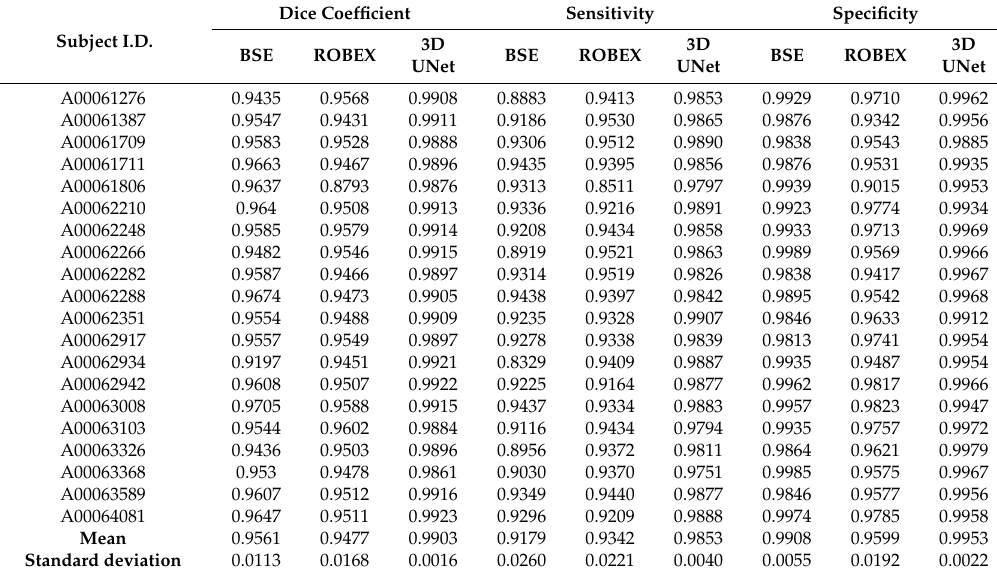
Table 2. Overall quantitative analysis and comparison of 3D-UNet with Brain Surface Extractor (BSE) and Robust Brain Extraction (ROBEX) against manual segmentation results for the test brain MRIs datasets. The best values are emboldened.